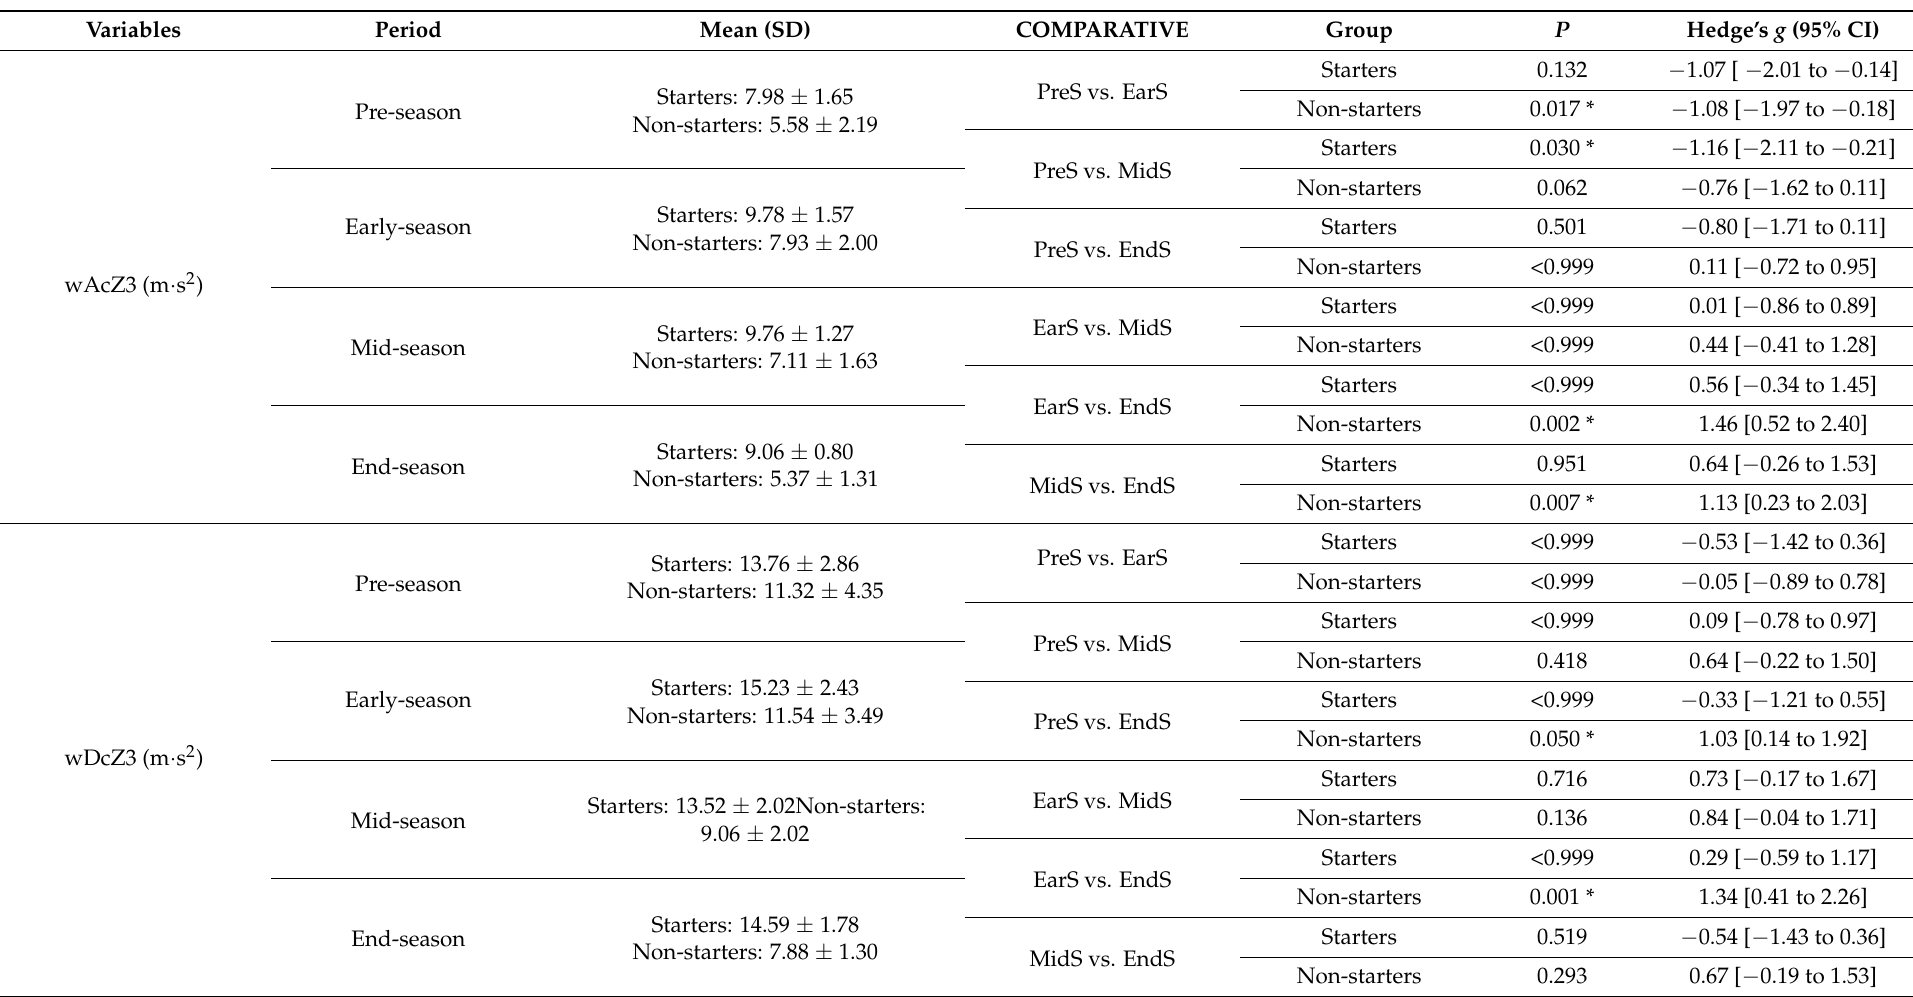
Table 5. Within-group differences for pairwise comparisons between season periods in wAcZ3 and wDcZ3 for both non- and -starters players.